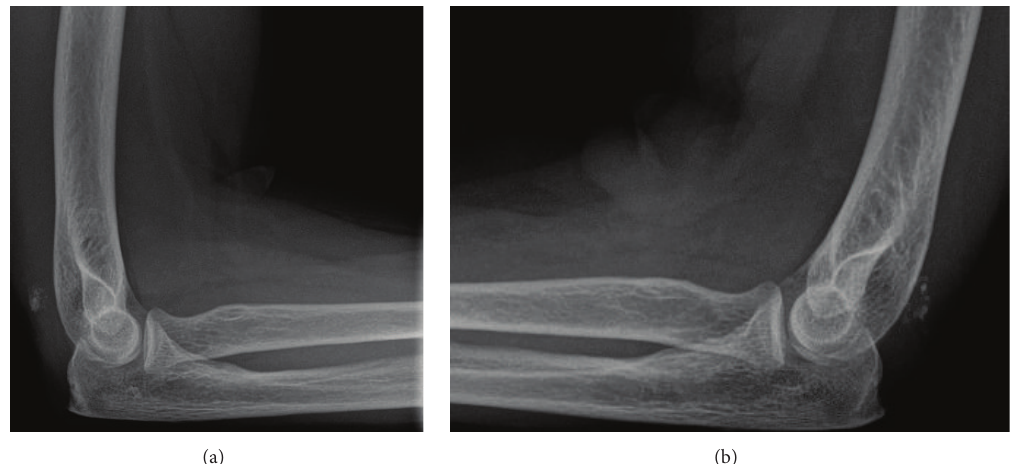
Figure 1: Lateral radiographs showing triceps tendon avulsion with a small piece of bone from the olecranon of the left (a) and right (b) elbow.